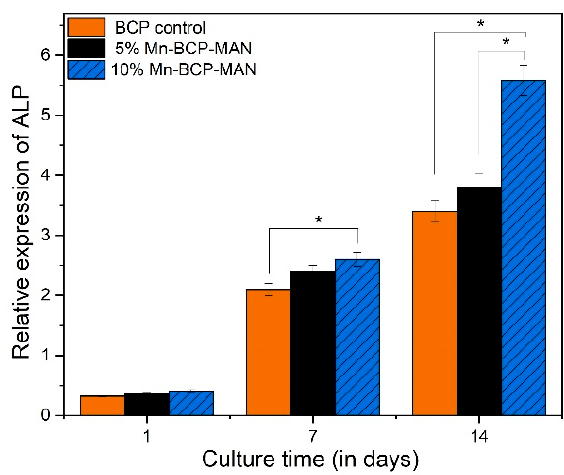
Figure 13. Relative expression of alkaline phosphatase; * denotes p <